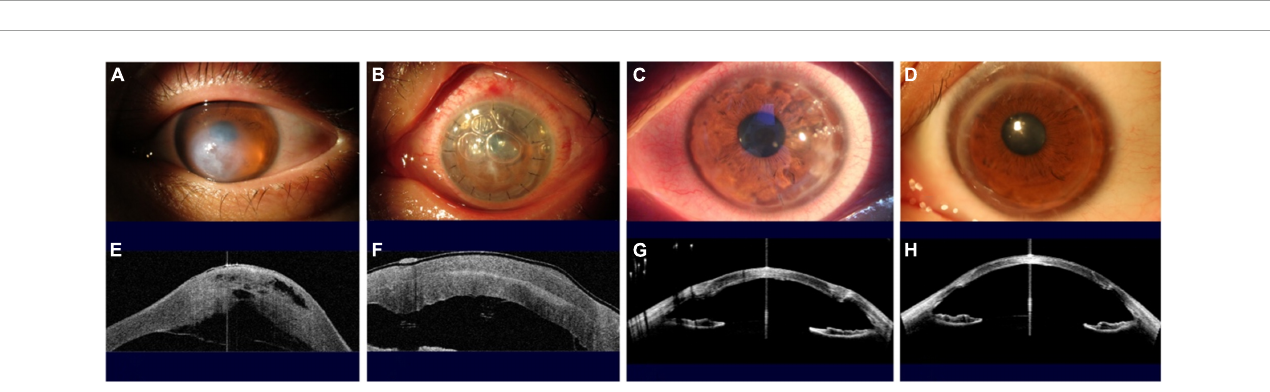
FIGURE4 Slit-lamp photographs and anterior segment optical coherence tomography (AS–OCT) scans show the evolution of a patient with ACH treated using the novel techniques. (A,E) Acute onset ACH, with severe edema of the corneal stroma evident under slit-lamp examination and with a DM break and detachment observed by AS-OCT. (B,F) One day after the first-stage surgery, at presentation, with double layers of cornea observed on slit-lamp and AS-OCT examinations, with no corneal edema and with DM attached. (C,G) One week after the second-stage surgery, the corneal graft, which was the same graft used in the first-stage operation, had survived and attached to the host’s residual stroma bed with a healed DM and corneal endothelial. (D,H) One year after the second stage surgery, the cornea was transparent and the logMAR CDVA was